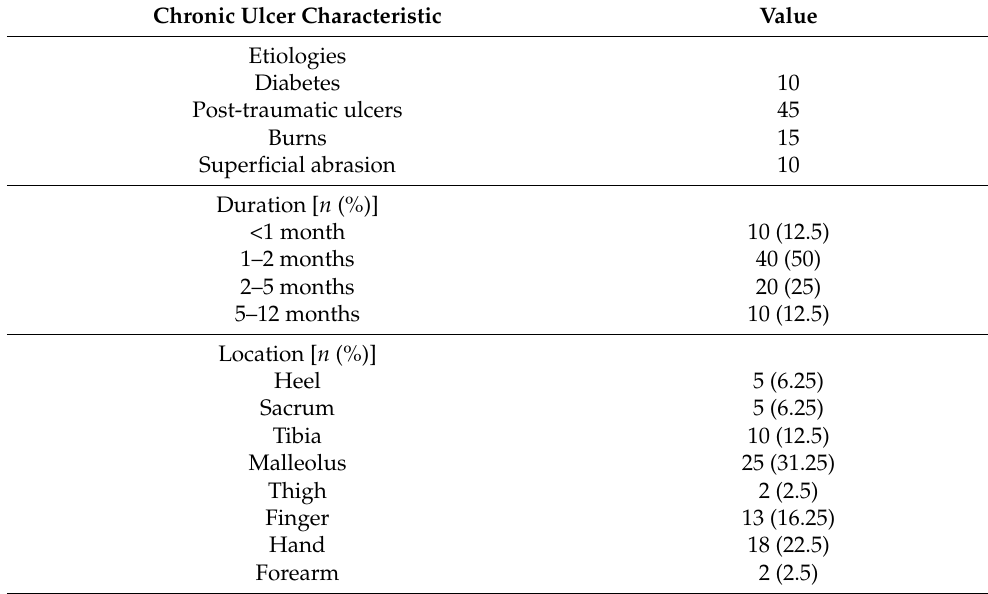
Table 2. Baseline chronic ulcer characteristics for the study patients ( n =